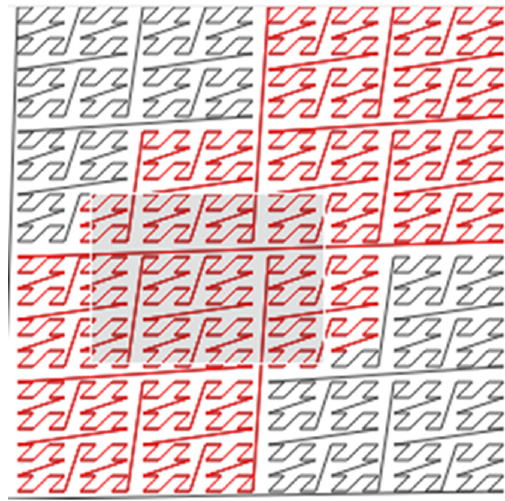
Figure 7. The red area shows Morton codes between Z min and Z max.